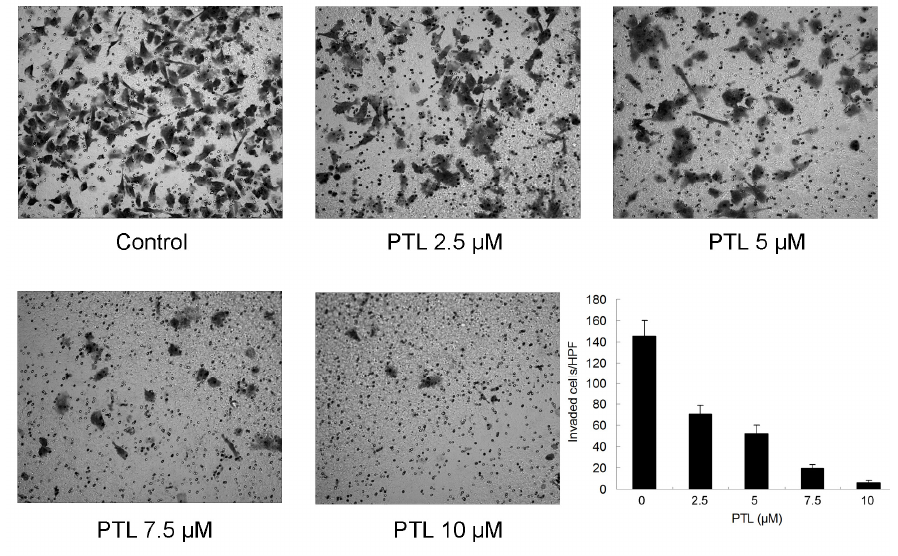
Figure 6. Effect of parthenolide on 5637 cell invasion. Cells were treated with different concentrations of parthenolide for 48 h, then were fixed and stained and counted. The invaded cells were expressed as a